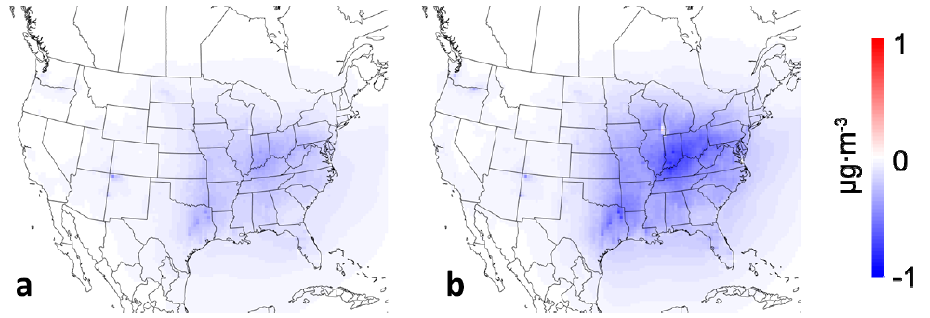
Figure 7. Differences in mean PM 2.5 concentrations in µ g m − 3 , across the domain for the year ( a ) 2030 and ( b ) 2050 between BAU and CES40B.